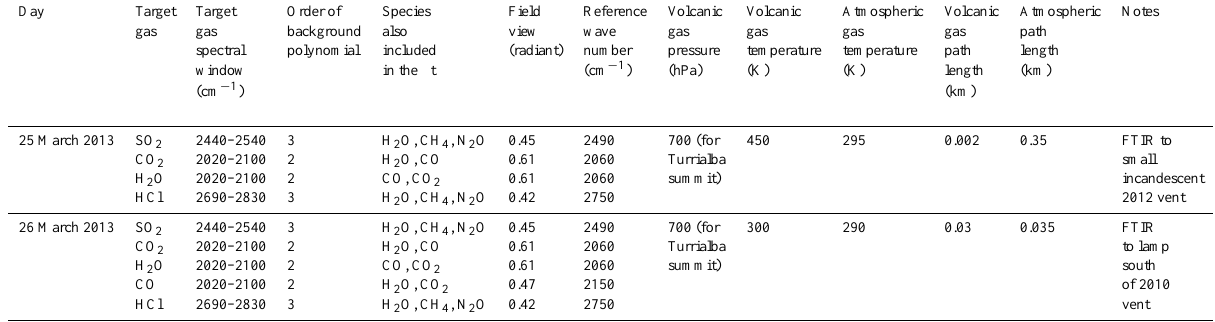
Table 1. Spectral micro-window and all other parameter used for fitting the target gas species.